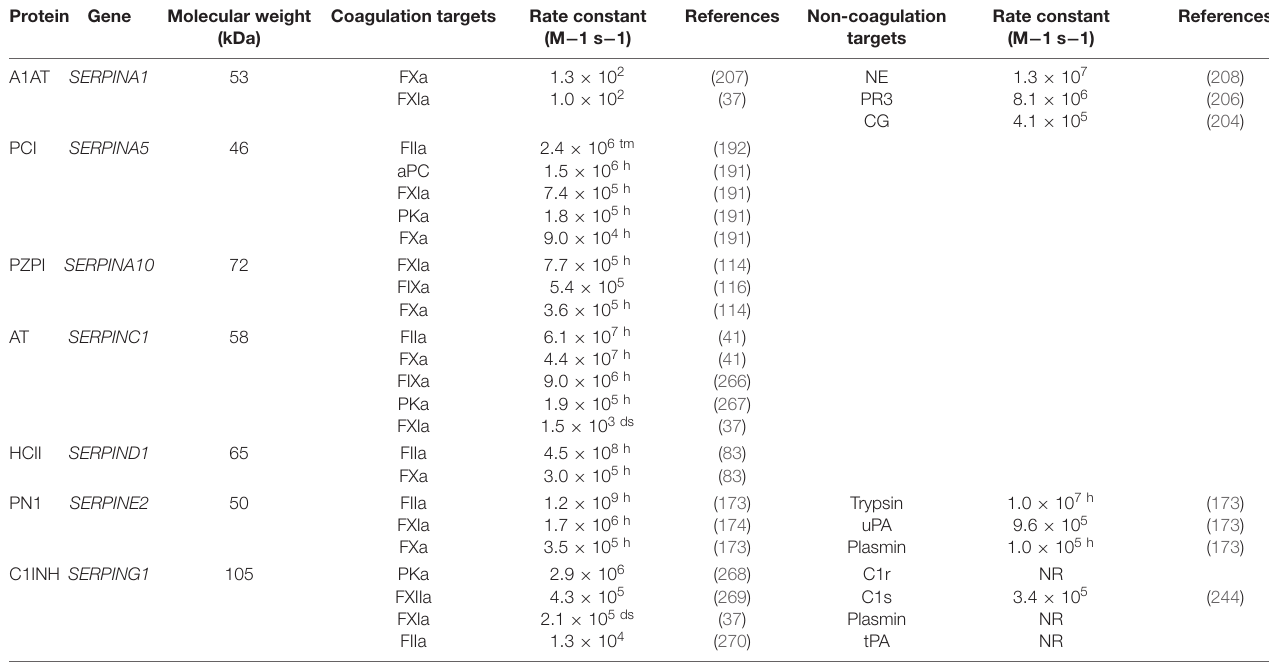
TABLE 1 | Anticoagulant SERPINs and targets. Protein Gene Molecular weight